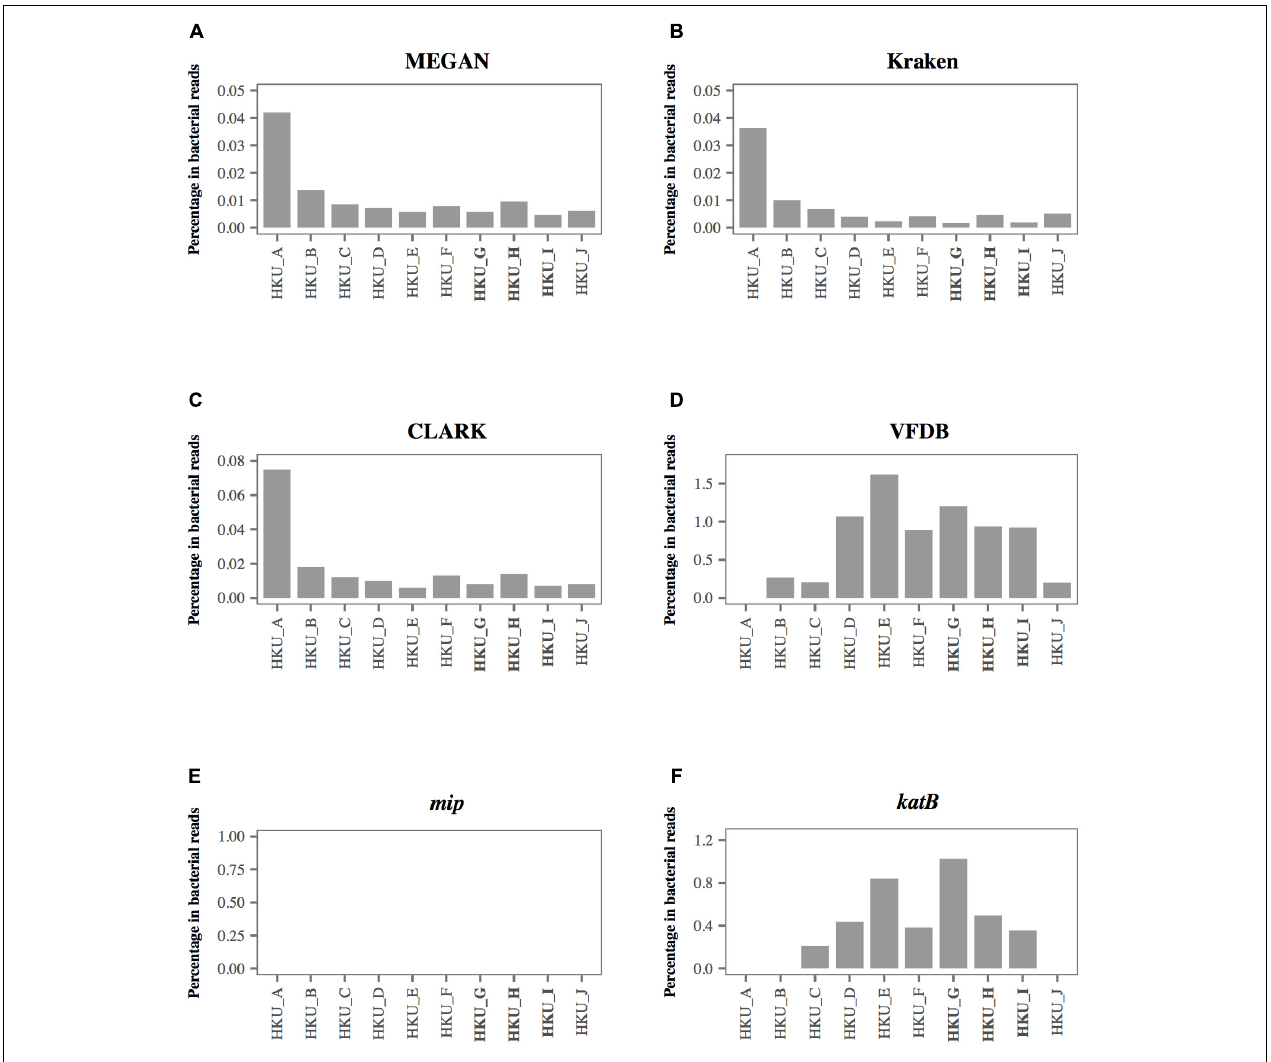
FIGURE 4 | The percentage of shotgun reads identified as Legionella pneumophila using 6 different database-based search methods. Proportion of shotgun sequence reads identified as L. pneumophila by (A) MEGAN with the NCBI-NT database, (B) Kraken with RefSeq archaea, bacteria, and viruses, (C) CLARK with RefSeq archaea and bacteria, (D) VFDB, (E) mip gene, and (F) katB gene. The bold labels indicate L. pneumophila -positive samples using nested